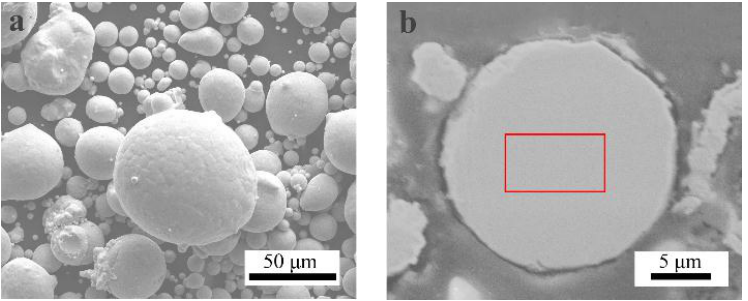
Figure 1. ( a ) Morphologies and ( b ) cross section of the gas-atomized FeCoCrNiMo0.2 HEA powders. Table 2. Chemical compositions of gas-atomized FeCoCrNiMo0.2 HEA feedstock powder. Elements Actual Composition (at. %) Nominal Composition (at. %) Fe 23.64 23.81 Co 23.76 23.81 Cr 23.89 23.81 Ni 23.40 23.81 Mo 5.31 4.76